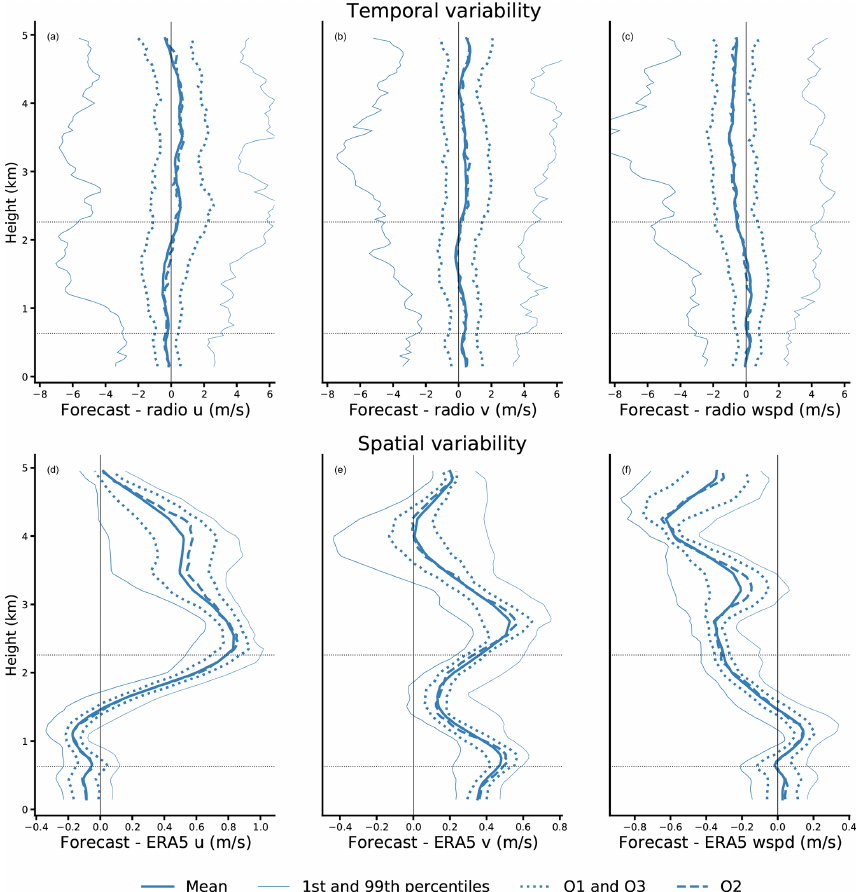
Figure 8. Statistical distribution over time of the forecast error with respect to the radiosondes for all levels up to 5km (a–c) . Statistical spatial distribution for the 61 extraction points of the difference between the forecast and ERA5 (d–f)